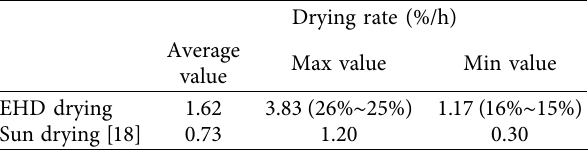
Figure 4: Plot of the moisture content change in the electro- hydrodynamic (EHD) drying experiments under simulated In- donesian conditions (every 10min). Table 1: Comparison of drying rate between electrohydrodynamic (EHD) drying and sun drying.